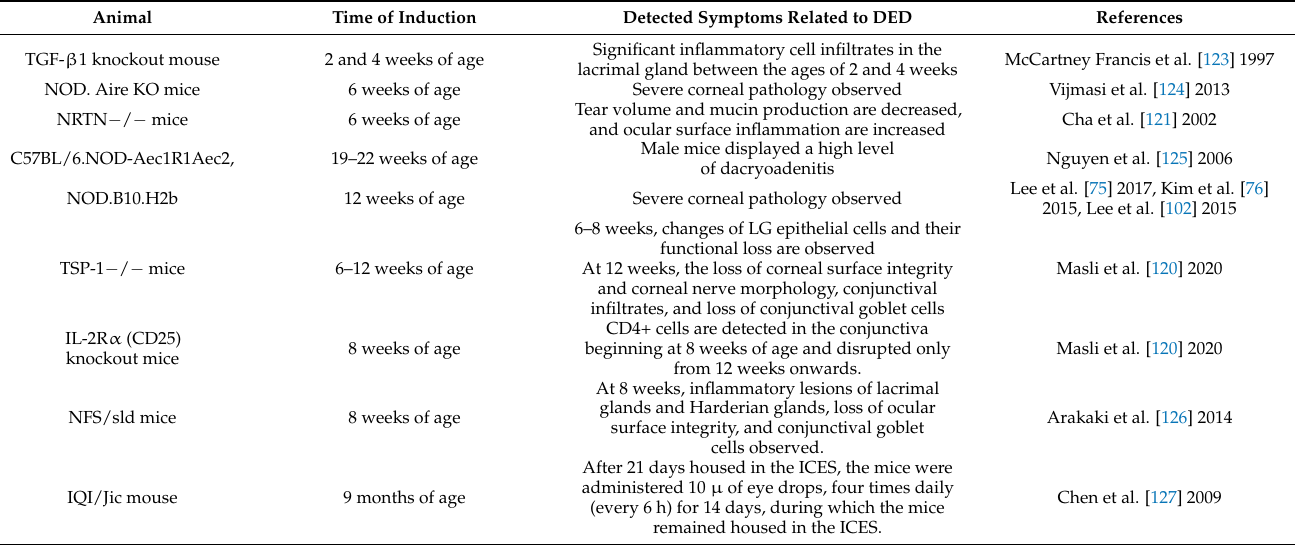
Table 6. Some selected genetic mouse models and time point DED-related